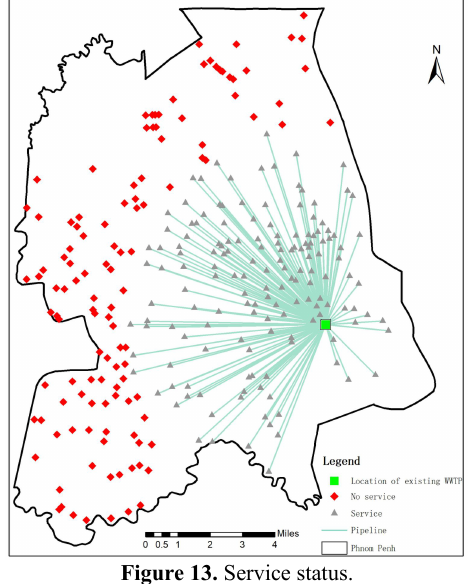
Figure 13. Service status.